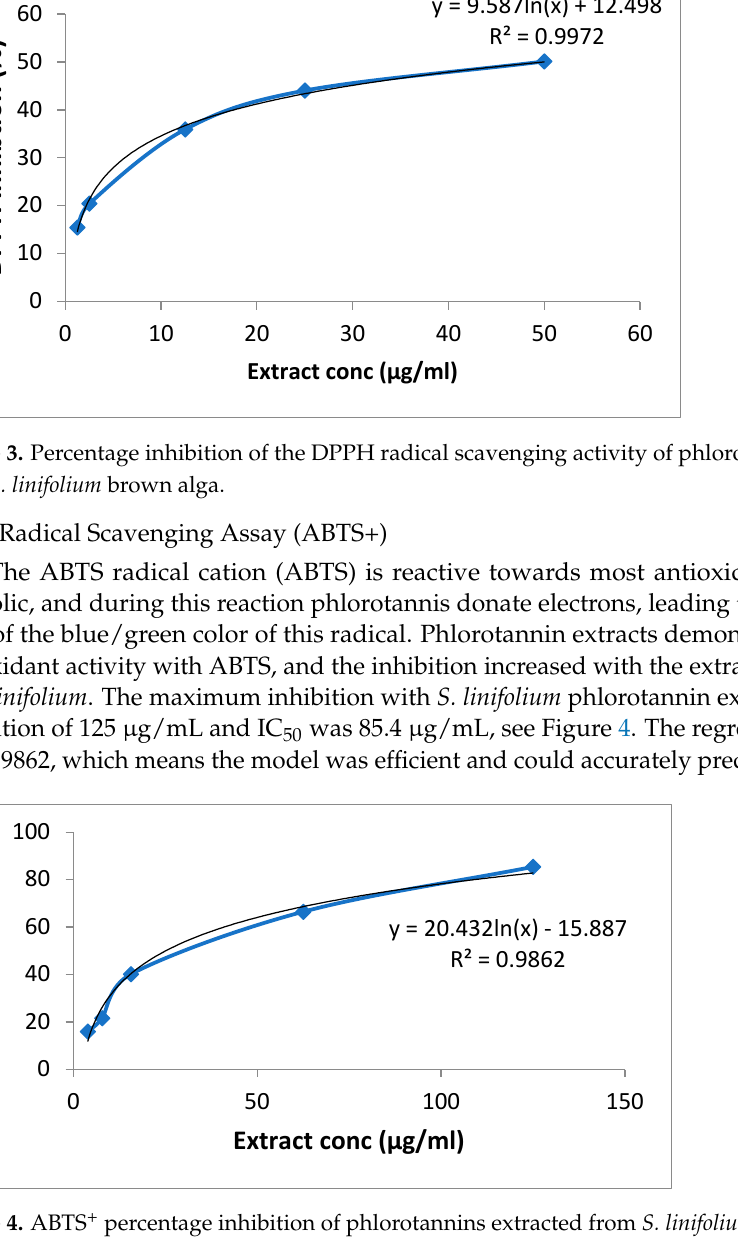
Figure 5. Cytotoxicity of phlorotannins extracted from S. linifolium brown alga on the WPMY1 normal cell line. 3.6. In Vivo Study The e ff ect of the phlorotannin extracts on the di ff erently treated groups’ serum glucose and insulin levels was evaluated. The results in Table 2 show a signi fi cant in- crease of serum glucose in the diabetic rats (596 mg/dl) compared to the normal control group (130.75 mg/dL), where S. linifolium phlorotannin extract lowered the level of glu- cose (111.25 mg/dL) below the normal control. Meanwhile, a signi fi cant decrease in se- rum glucose levels in the diabetic rats was observed after administration (60 mg/kg) of phlorotannins extracts of S. linifolium ; the glucose levels of diabetic rats that were ad- ministered phlorotannin extracts of S. linifolium were 159.25 b ± 20.22. In addition, the results in Table 3 demonstrate the rise in serum insulin in the rats treated with S. linifolium phlorotannins above the normal control. There was no signi fi cant change in the serum insulin levels in diabetic rats treated with S. linifolium phlorotannins (5.03 a ± 1.43 µLU/mL) and the normal controls (5.302 a ± 1.336 µLU/mL). These results indicated that the S. linifolium phlorotannins promoted the β -Cell in the pancreas to secret insulin, which can be used to treat diabetes. The primary enzyme in saliva and pancreatic juice, α -amylase, is responsible for releasing the bonds that allow carbs to break down into glucose and maltose. The enzyme glucosidase, which is present in the brush border of the small intestine and is responsible for cleaving 1–4 linkages and releasing glucose for en-